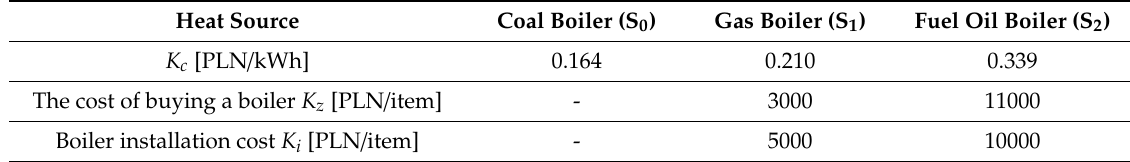
Table 9. Economic costs of heat energy and the purchase and installation of boilers.